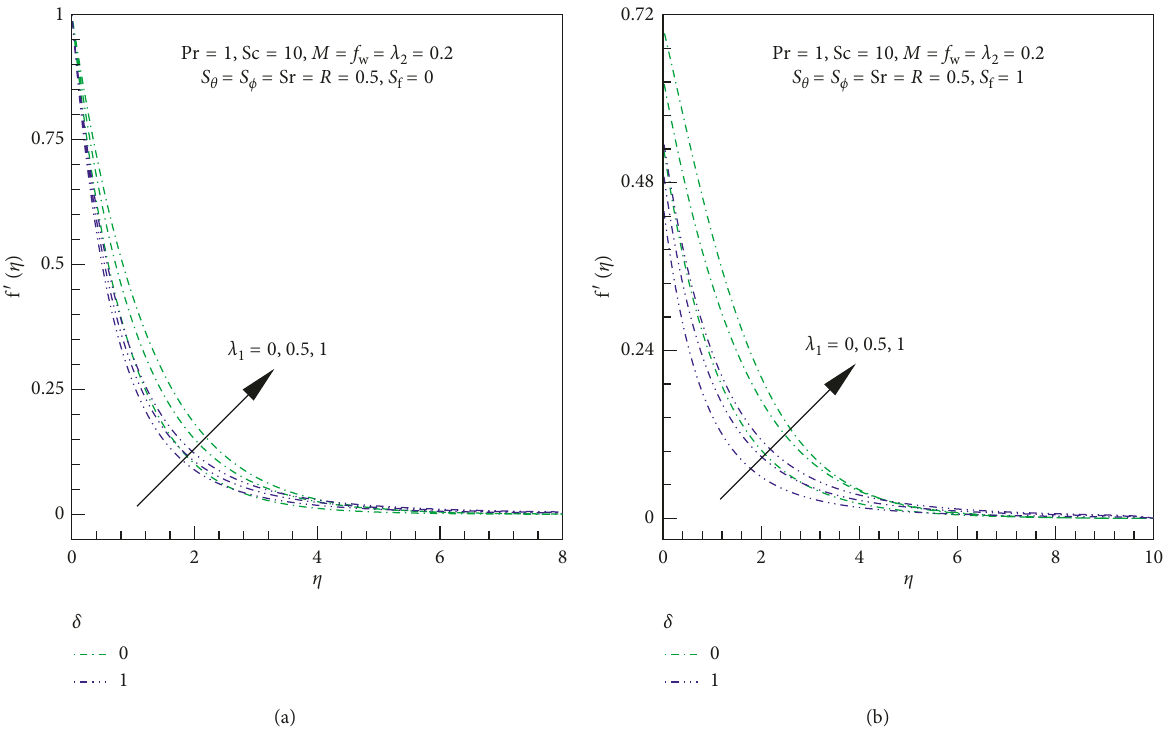
Figure 3: Effects of λ 1 and δ on dimensionless velocity. (a) No hydrodynamic slip. (b) With hydrodynamic